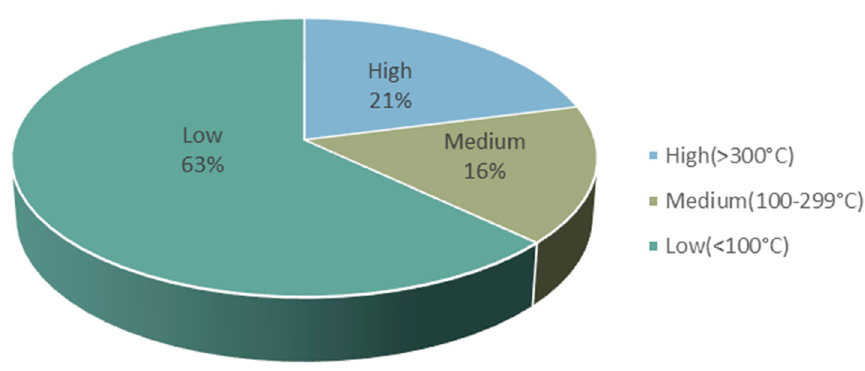
Figure 2. Waste-heat temperature distribution. Adapted from [57].